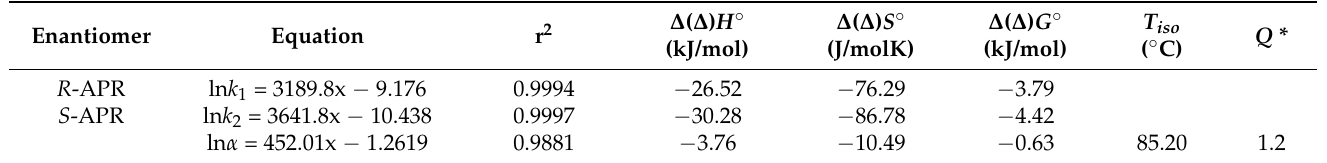
Table 2. Calculated thermodynamic parameters of APR enantiomers on the Chiral-HSA column in 10 mM phosphate buffer/IPA 96/4 v/v %